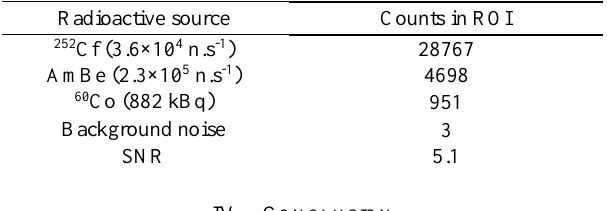
Fig. 4. Experimental two dimensional time histograms of all combinations of three coincident pulses in the measurements with 252 Cf (top left), AmBe (top right), 60 Co (bottom left) and background noise (bottom right). The color scale of 252 Cf and 60 Co plots is adjusted to that of AmBe (i.e. with a maximum near 2000 counts/bin). The ROI selected to provide best counting for the 252 Cf spontaneous fission coincidences while minimizing the parasitic ones is indicated, on each plot, by the red dashed-line rectangle (10 ns ≤ Δ 2-1 ≤ 30 ns and 10 ns ≤ Δ 3-2 ≤ 30 ns). T ABLE III NUMBER OF COUNTS IN THE REGION OF INTEREST OF FIG. 3 ( RED RECTANGLES ). SNR IS DEFINED BY THE RATIO OF THE COUNTS OBTAINED WITH 252 C F , OVER COUNTS OBTAINED WITH OTHER